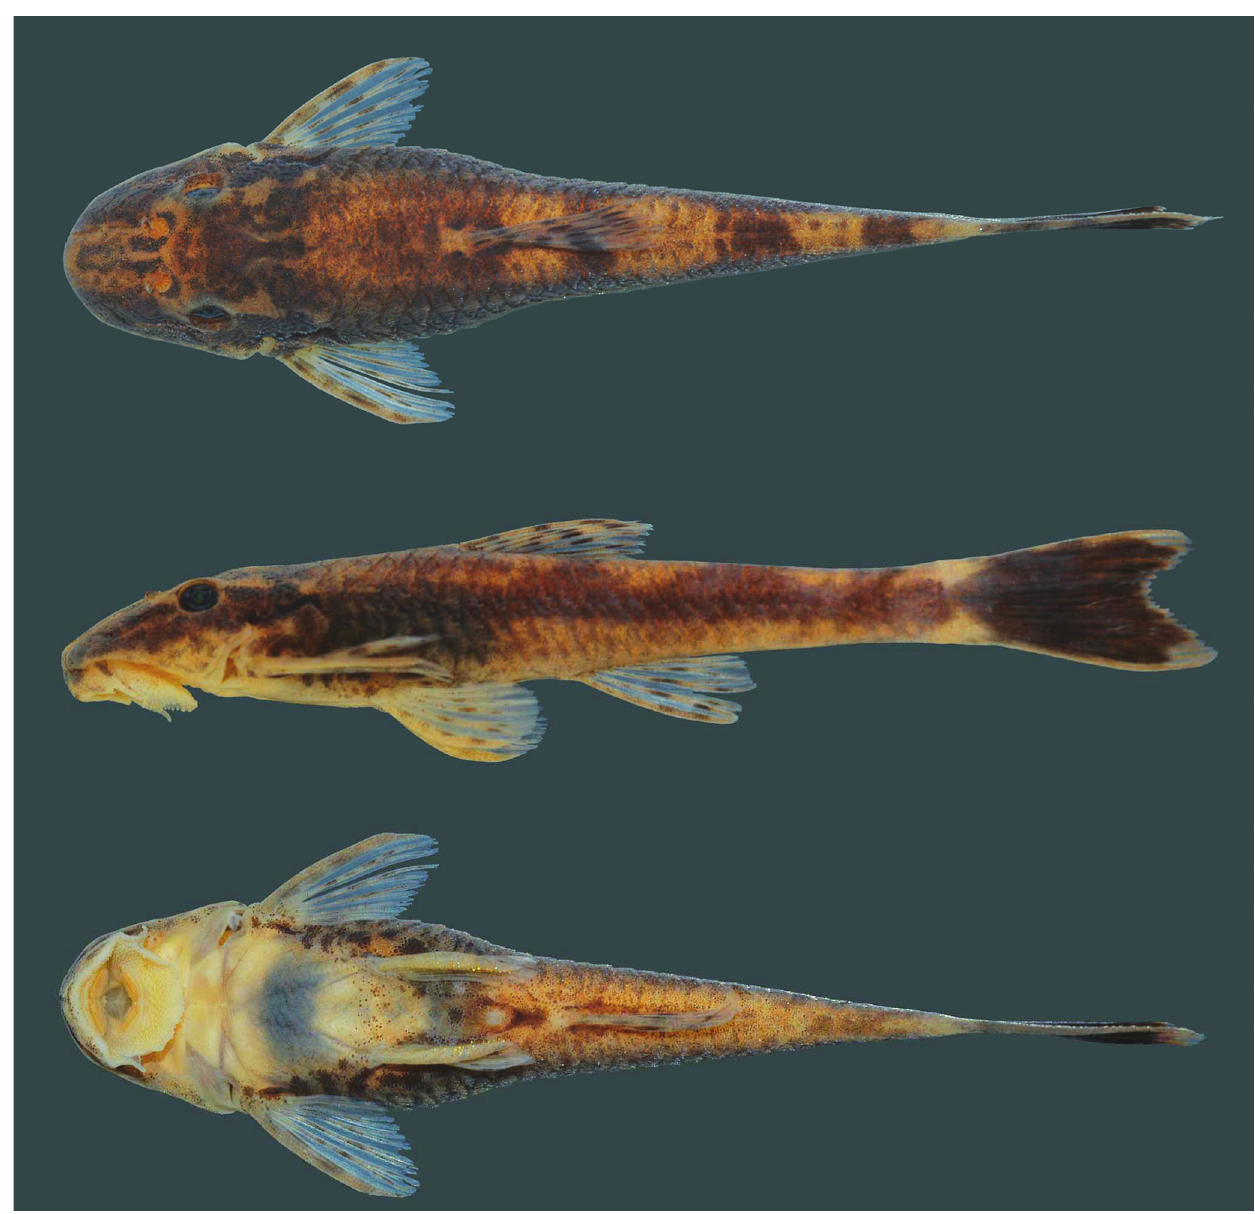
Fig. 4. Rhinolekos britskii , holotype, DZSJRP 6489, 32.2 mm SL, female, tributary of the córrego Arapuca, rio Paranaíba drainage, Bela Vista de Goiás, Goiás State,